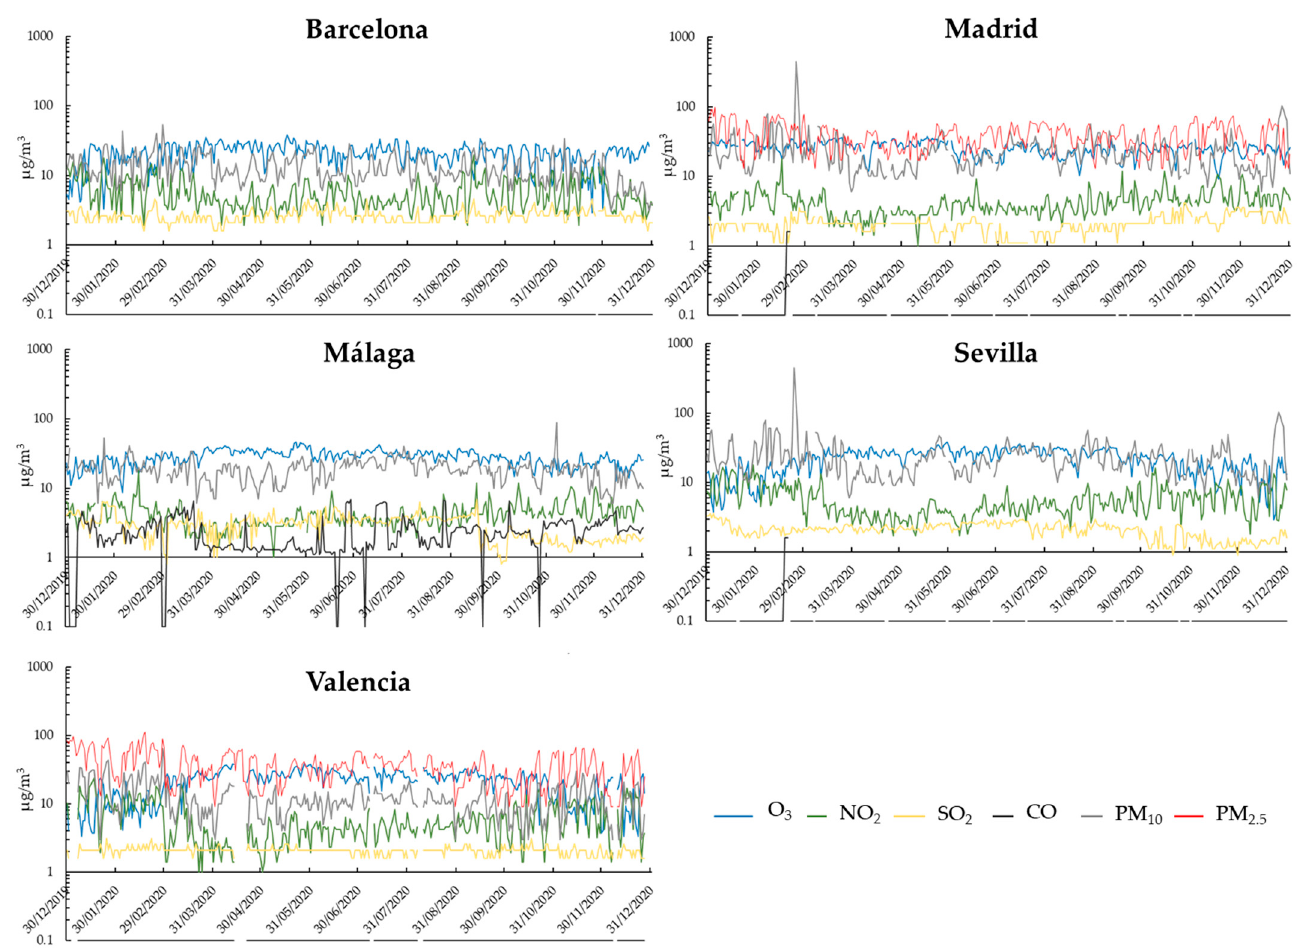
Figure 4. Atmospheric changes during 2020 in Barcelona, Madrid, Málaga, Sevilla and Valencia.